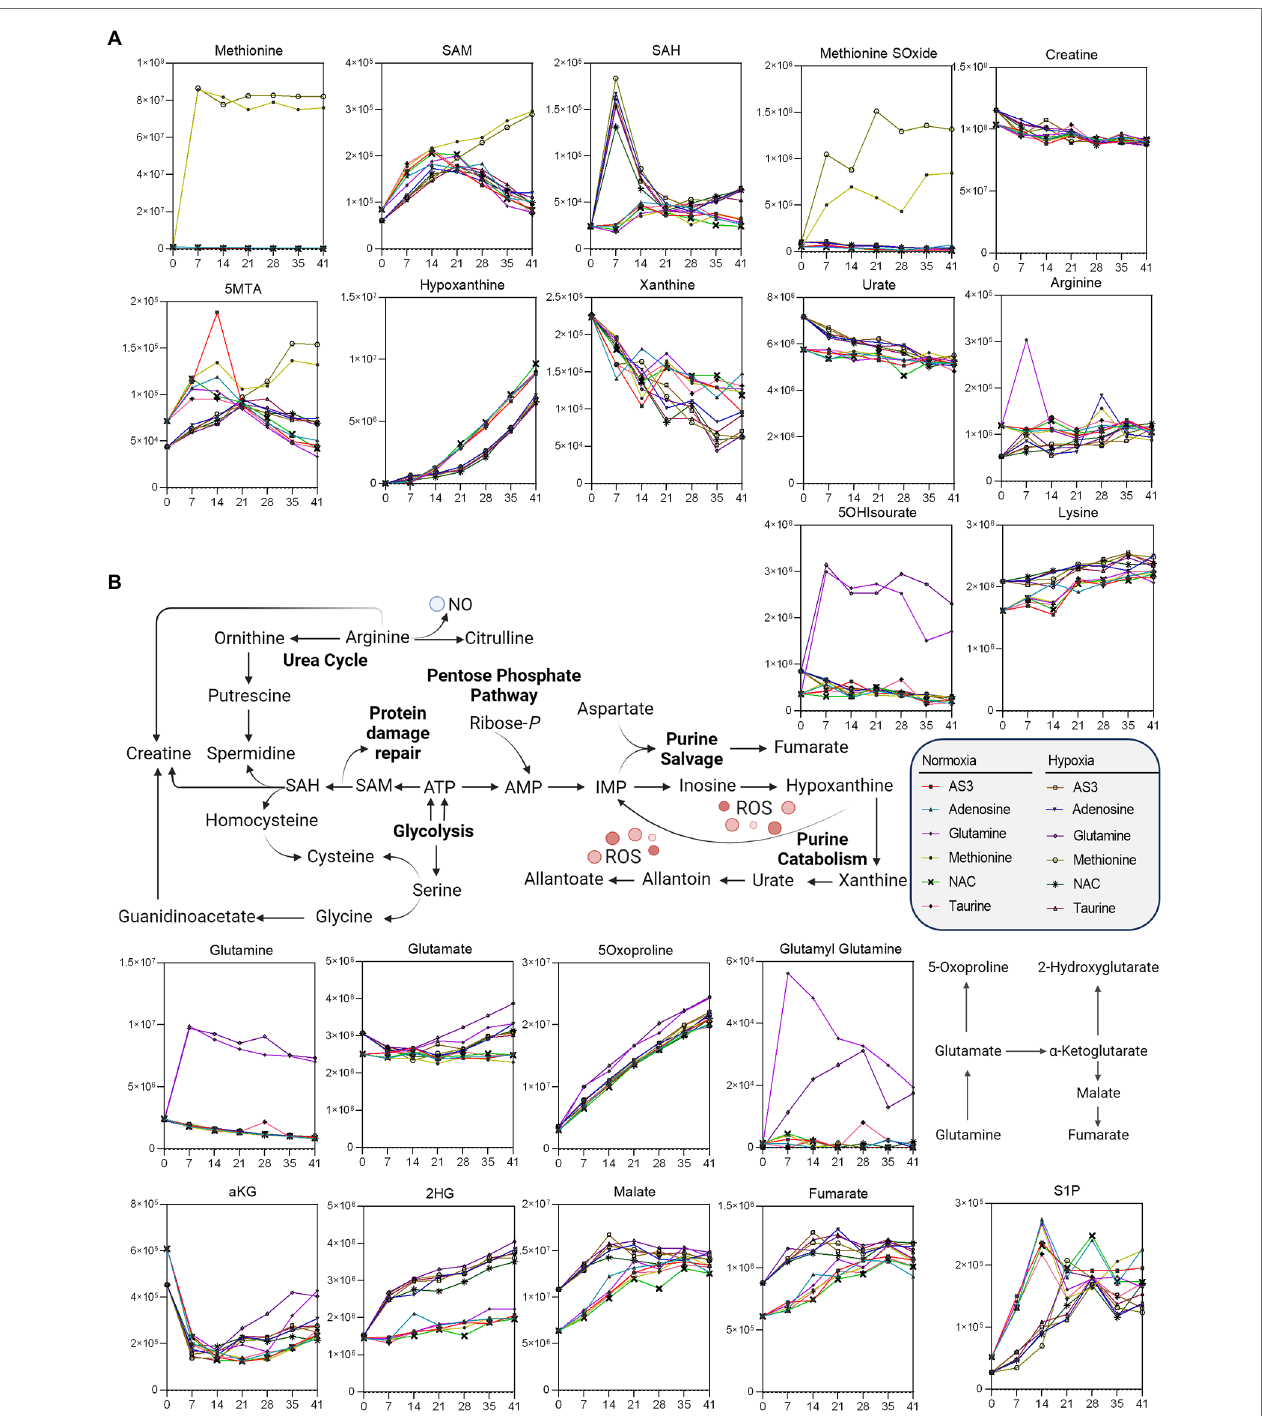
FIGURE 5 | Impact of hypoxia and storage additives on (A) methionine metabolism and purine oxidation and salvage, (B) glutaminolysis, and carboxylic acid